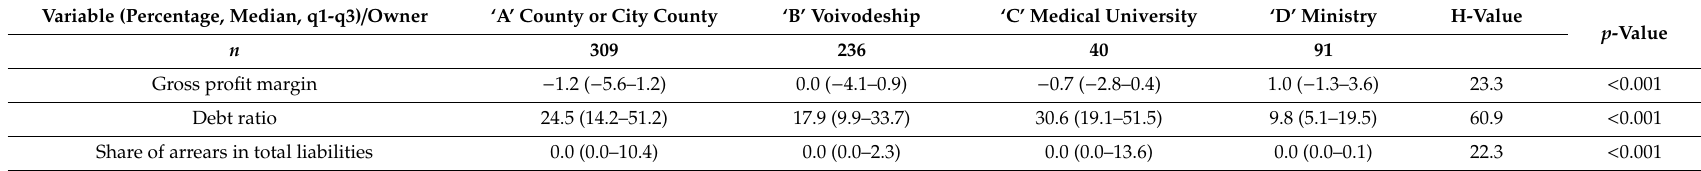
Table 3. Financial indicators per ownership group, in